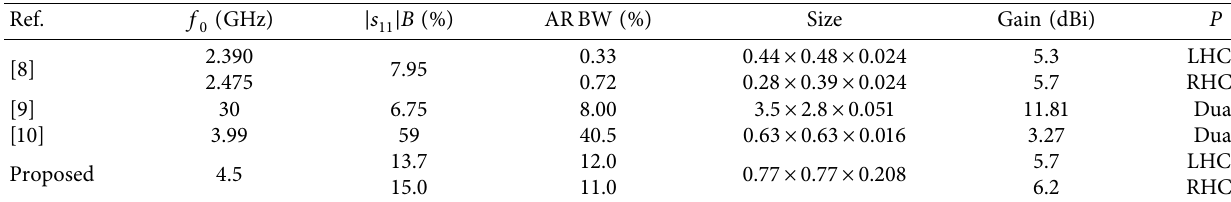
Figure 7: Under the close shot, the CP antenna picture of real products. (a) Side view. (b) Top view. Table 2: Comparison of CP antennas.